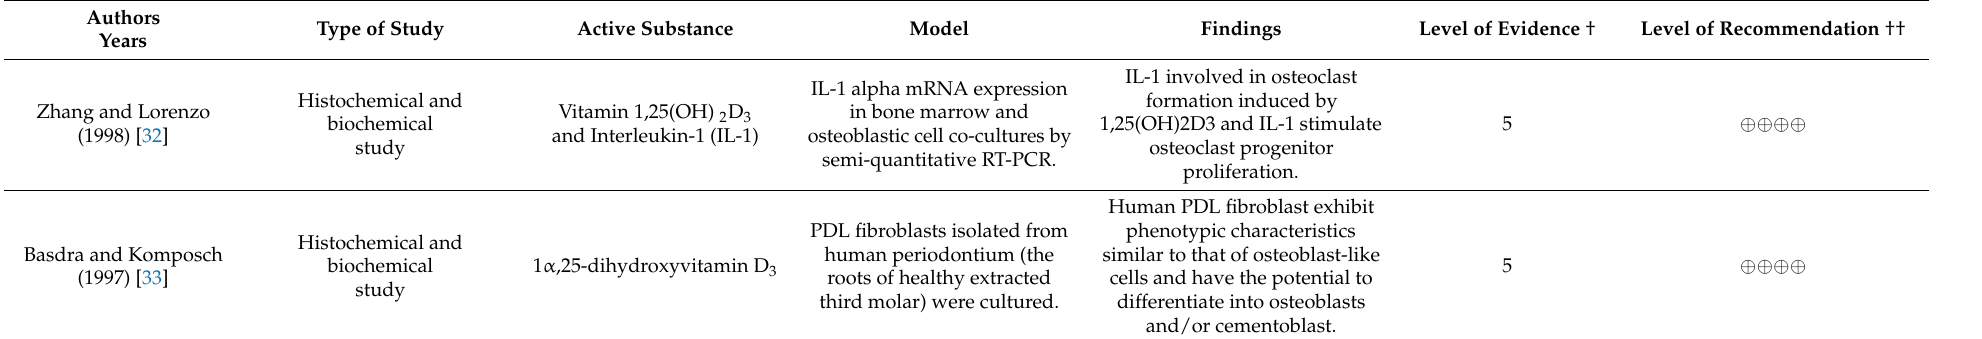
Table 2. The summary of two in vitro studies.